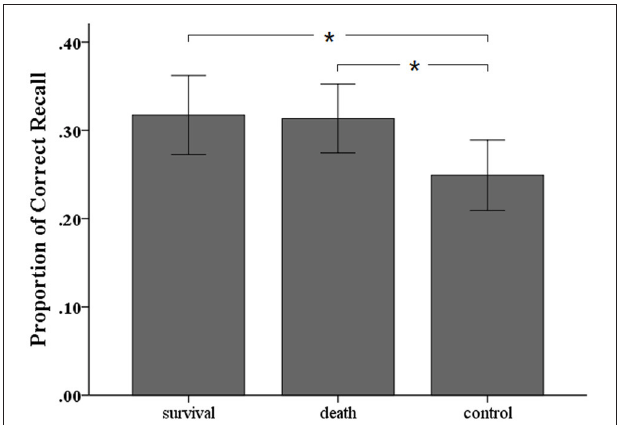
FIGURE 2 | Average proportion of correct recall sorted by different priming conditions in Experiment 2. Error bars indicate standard deviations in each group. * p < 0.05.